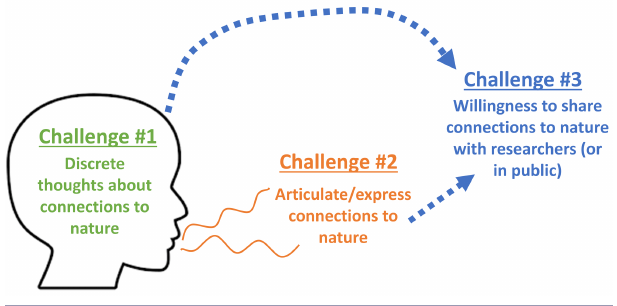
Fig. 1 . The three challenges to understanding connections to